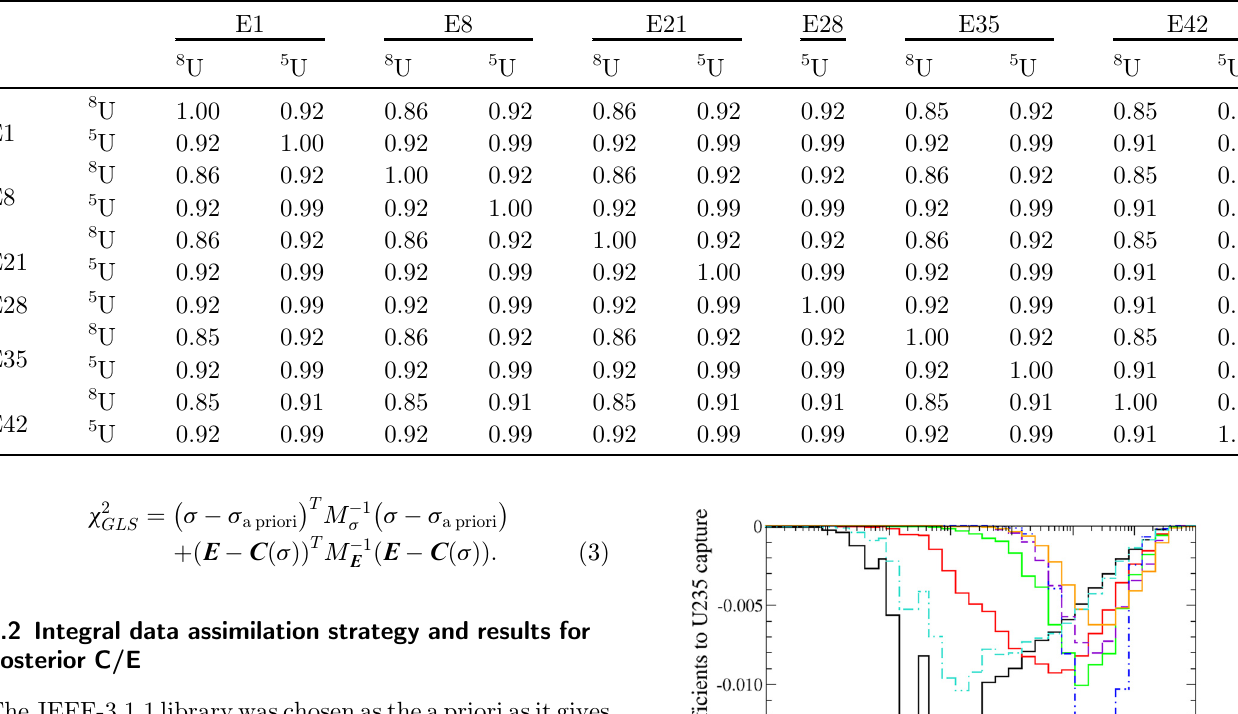
Table 2. Experimental correlation matrix for PROFIL-2A C/E.